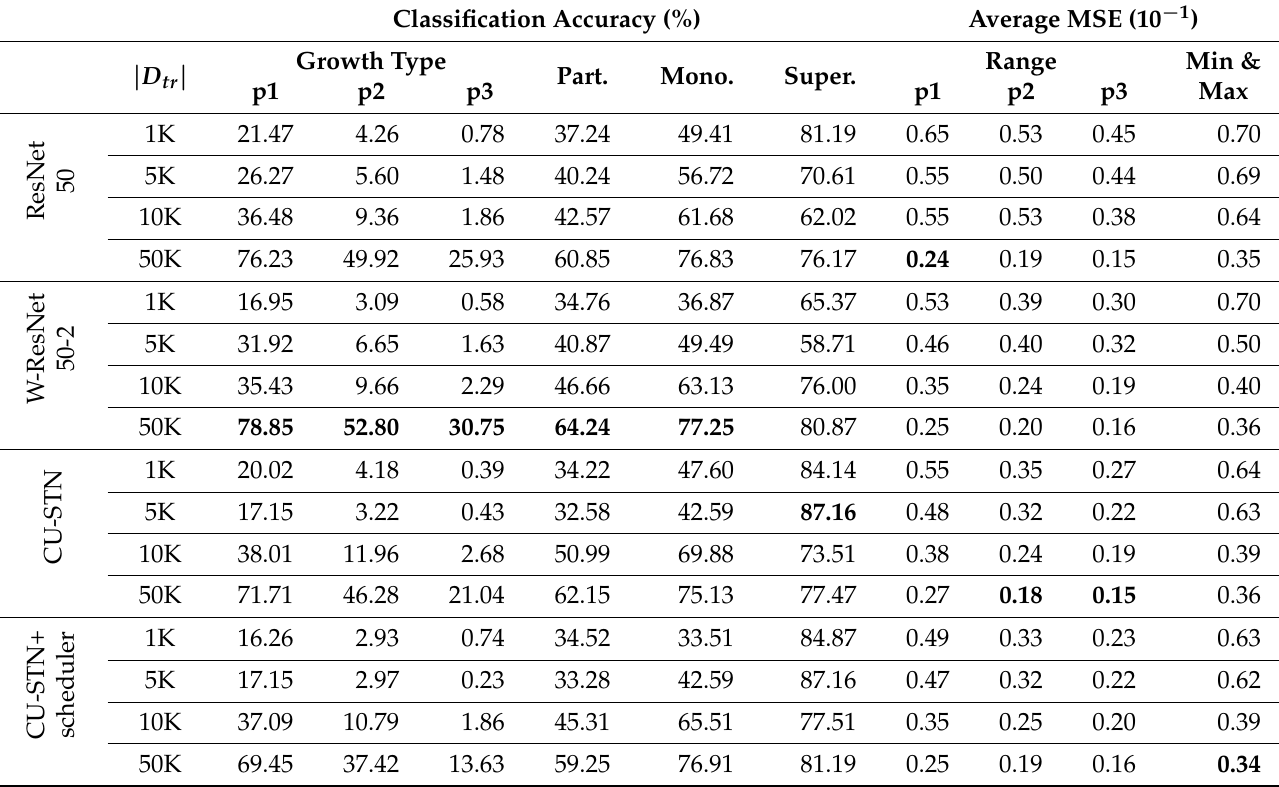
Table 5. Performance for all subtasks in synthetic test data (5000 samples; part., the number of partitions; mono., monotonic- ity; super., superiority; | D tr | , size of training and validation data; MSE, mean square error; W-ResNet-50-2: Wide-ResNet-50-2). Classification Accuracy (%)